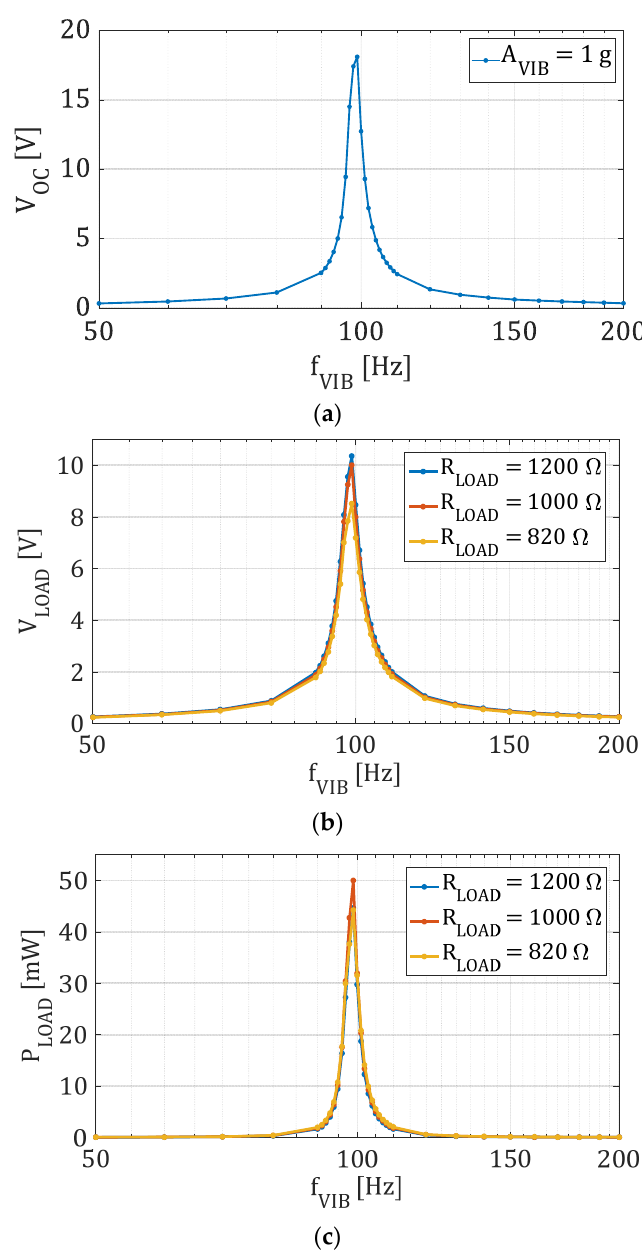
Figure 7. Measurements carried out on the commercial harvester model-D by ReVibe. ( a ) Open-circuit voltage amplitude; ( b ) output voltage amplitude for different loads; ( c ) extracted average power for different loads.